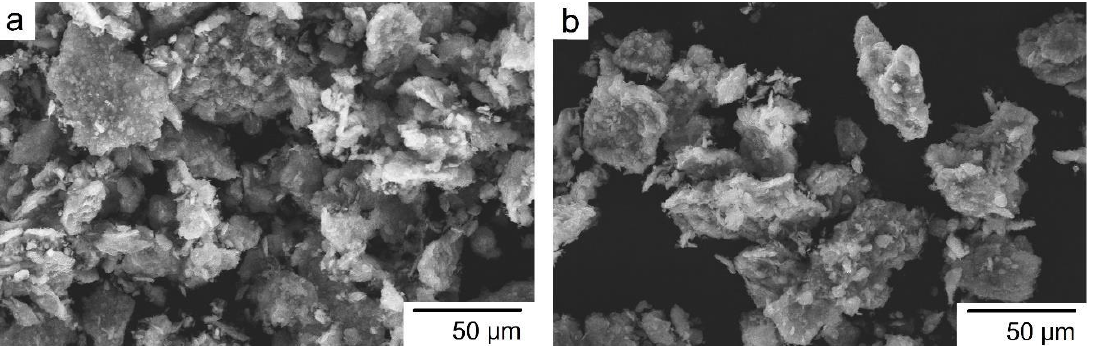
Figure 3. SEM images of the samples: ( a ) TiC-900; ( b ) TiC-1000.